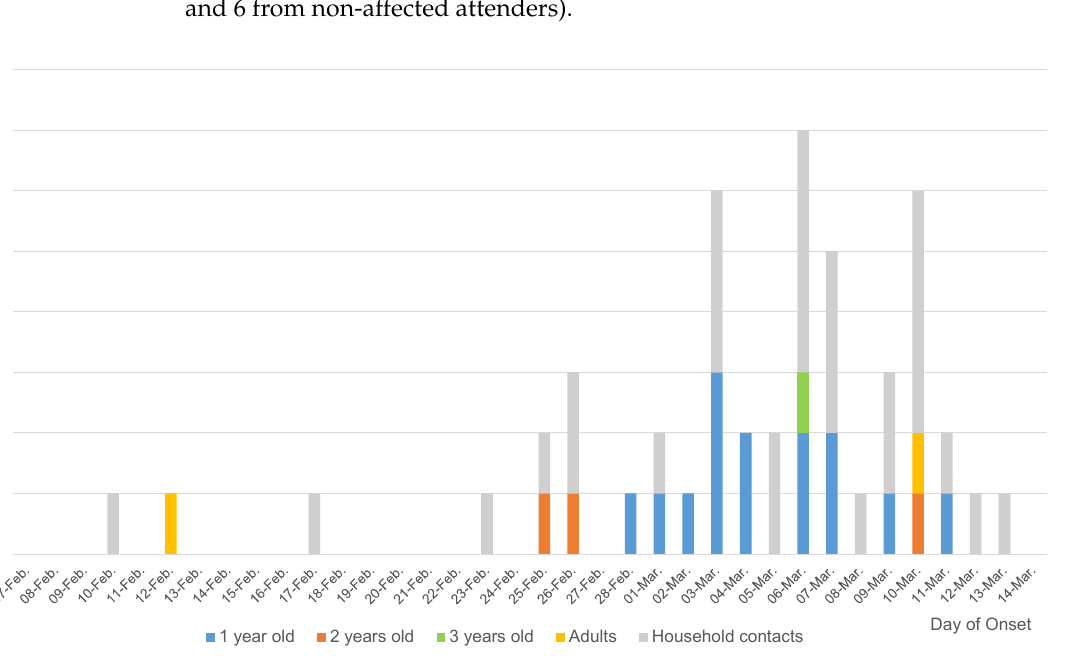
Figure 1. Epidemic curve of cases according to the day of symptom onset. The overall AR was 26.3% (20/76) for daycare center attenders and 17.2% (29/169) in household contacts. Considering daycare center attenders and their household contacts jointly, the AR was 20% (49/245), 17.2% in males (22/128) and 23.1% in females (27/117) (RR 0.74 95 CI 0.45, 1.23). The mean age was 1 year 237.6 days (SD 176.5) in affected child attenders at the day- care center and 2 years and 54.6 days (SD 287.4) in non-affected child attenders ( p = 0.002).